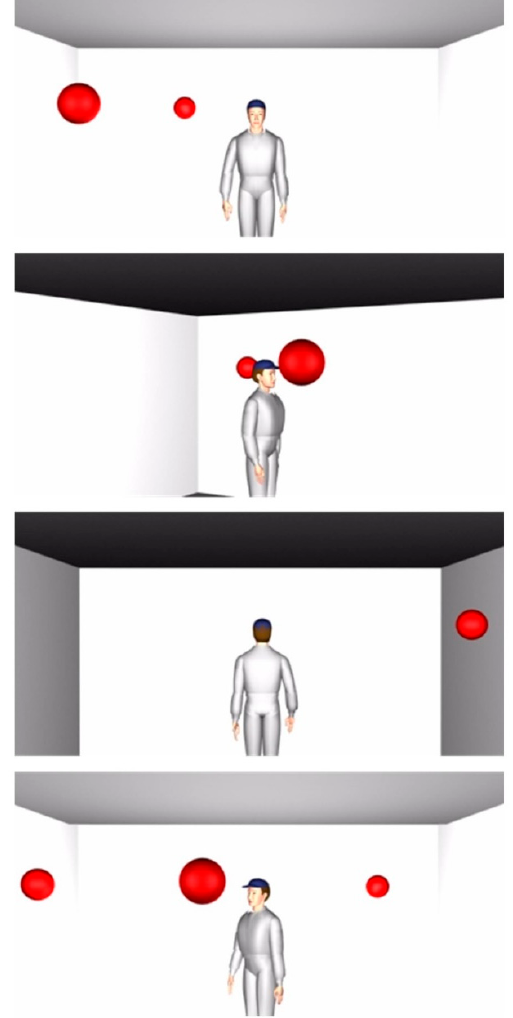
Figure 1. Stimuli of avatar and spherical balls. Each frame presented here demonstrates a different correct response for 1PP and 3PP. Stimuli were adapted from [87,15].